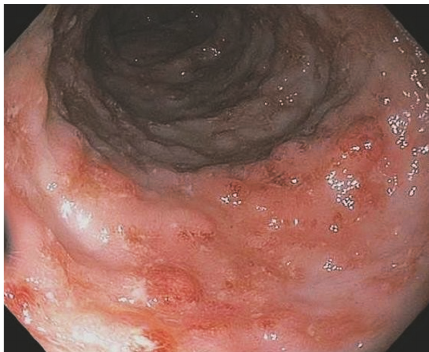
Figure 1: Colonoscopy showing portion of ascending colon with congested mucosa and aphthous and confluent ulcerations.